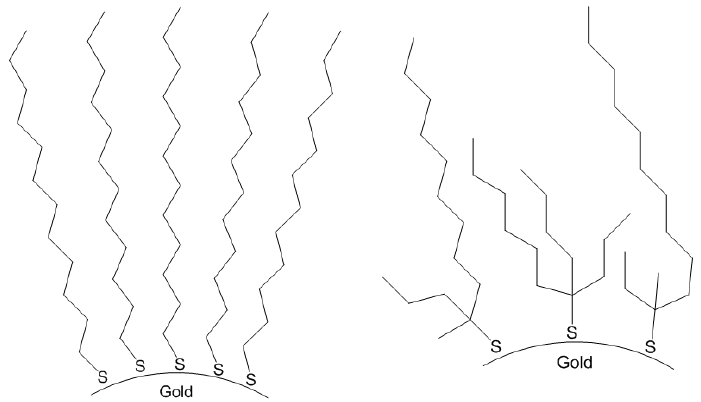
Figure 2. Schematic representation of gold nanoparticles covered with 1-dodecanthiol or tert -tetradecanethiol, respectively, assuming adsorption as